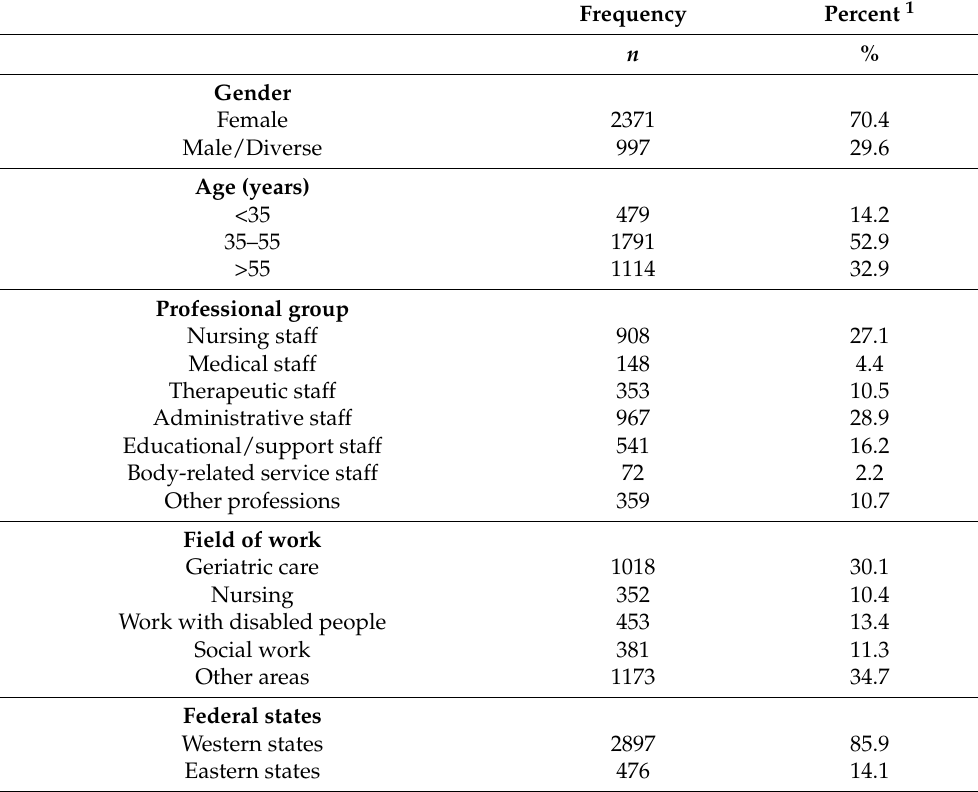
Table 1. Description of the study